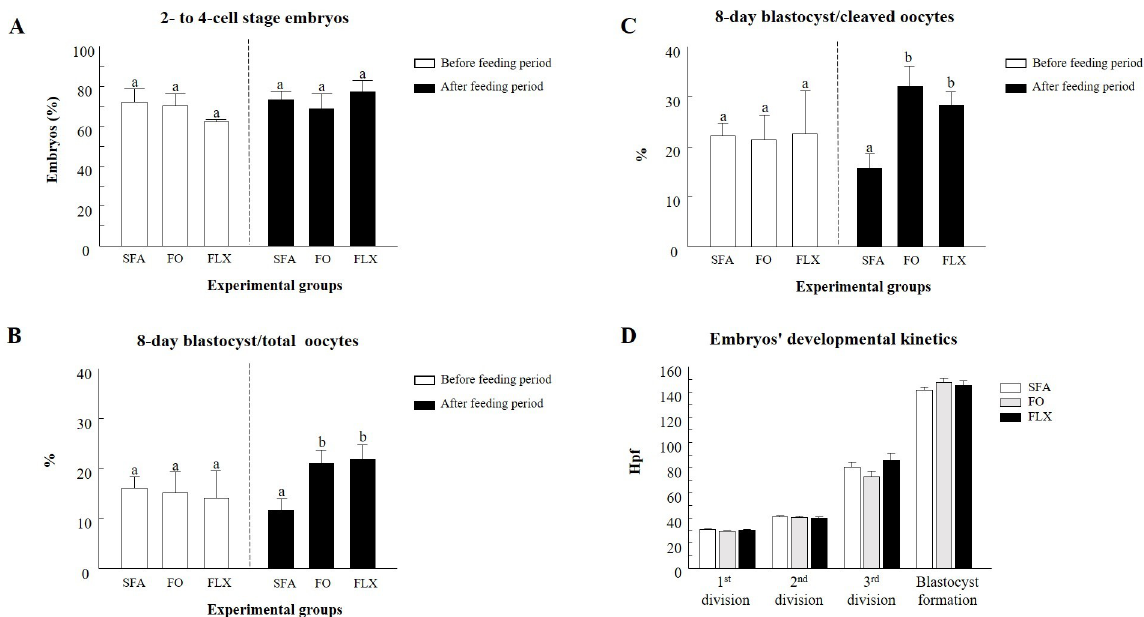
Fig 9. The effect of omega-3 sources flaxseed and fish oil on spermatozoa fertilization competence. (A) The proportion of 2- to 4-cell-stage embryos following in-vitro fertilization with pooled samples from each experimental group: saturated fatty acid (SFA; control), fish oil (FO), and flaxseed oil (FLX) taken from before and after the feeding trial. The proportion of embryos that developed into the blastocyst stage on day 8 post fertilization out of the total oocytes (B) or out of the cleaved oocytes (C). Data are presented as the mean ± SEM. (D) Embryo kinetics throughout the 1 st , 2 nd , and 3 rd divisions and blastocyst formation timing (hours post fertilization; hpf). Different letters above the columns indicate significant differences between groups ( P < 0.05).